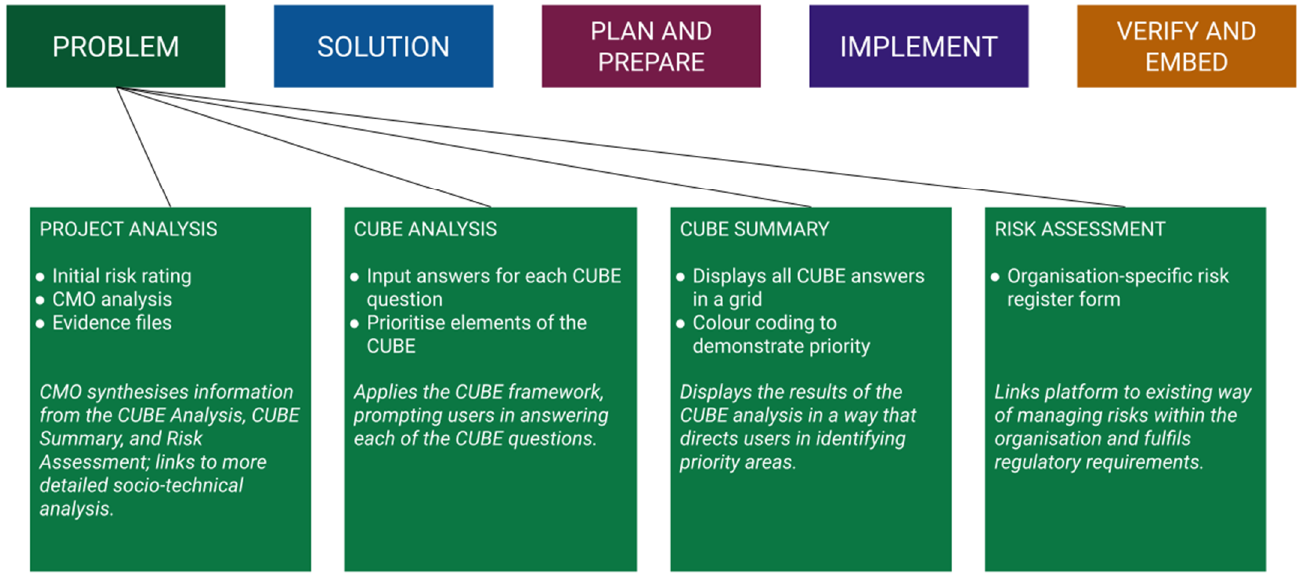
Figure 3. Risk and Project Analysis views in the ARK Platform.